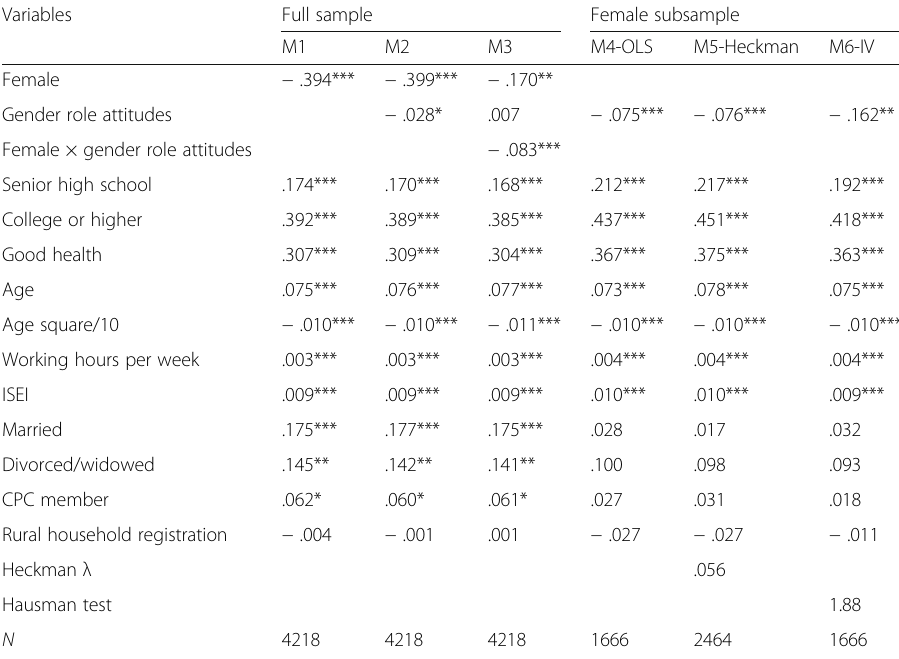
Table 2 Impact of gender role attitudes on labor income